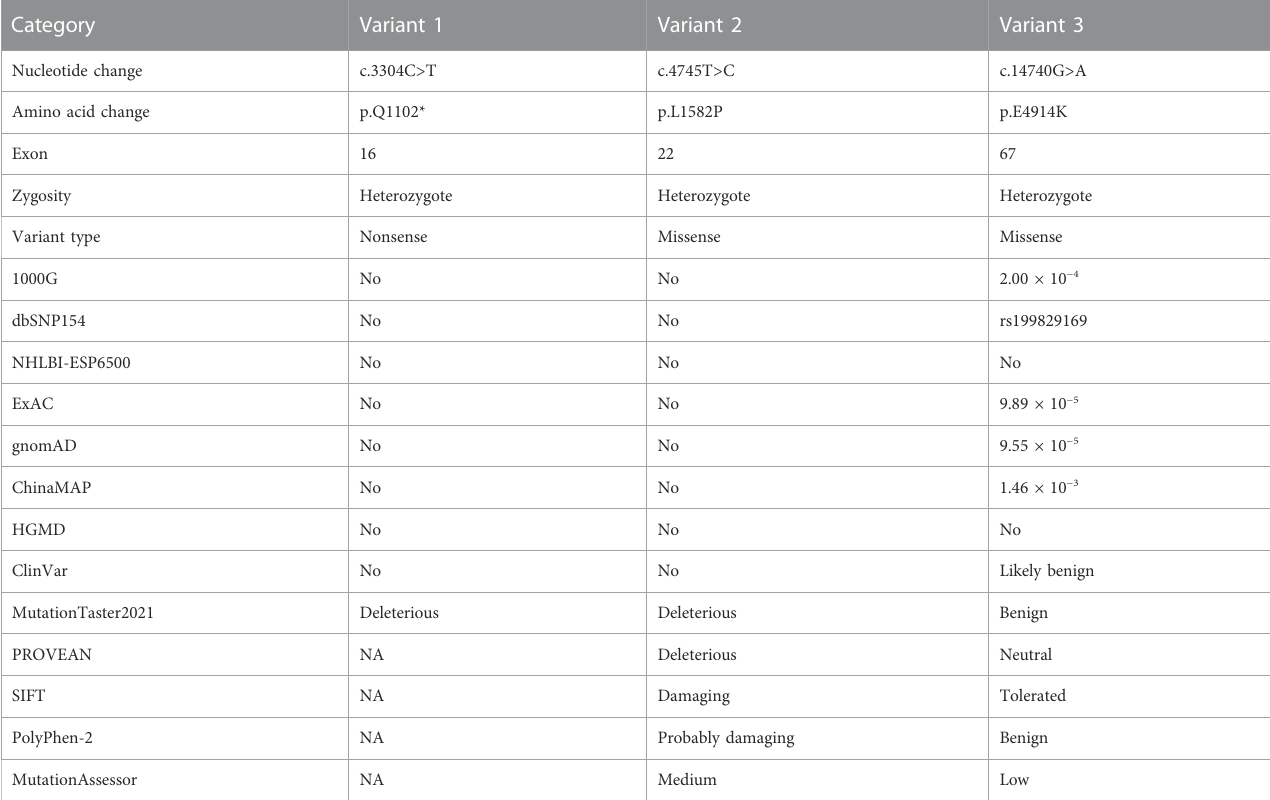
TABLE 1 Identi fi cation of USH2A variants in the